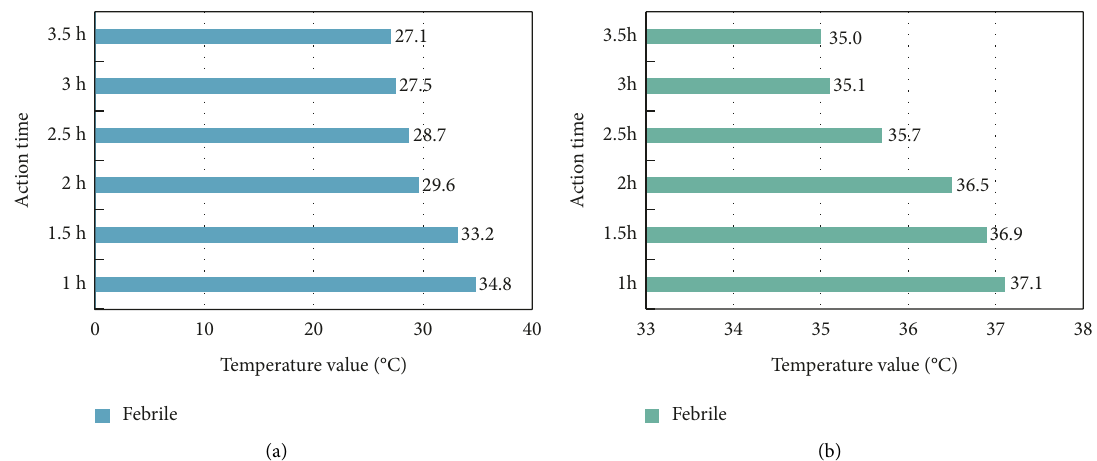
Figure 8: Clothing heat dissipation temperature under different materials. (a) shows the heat dissipation temperature of the garment under the graphene oxide material. (b) shows the heat dissipation temperature of clothing under traditional design materials.